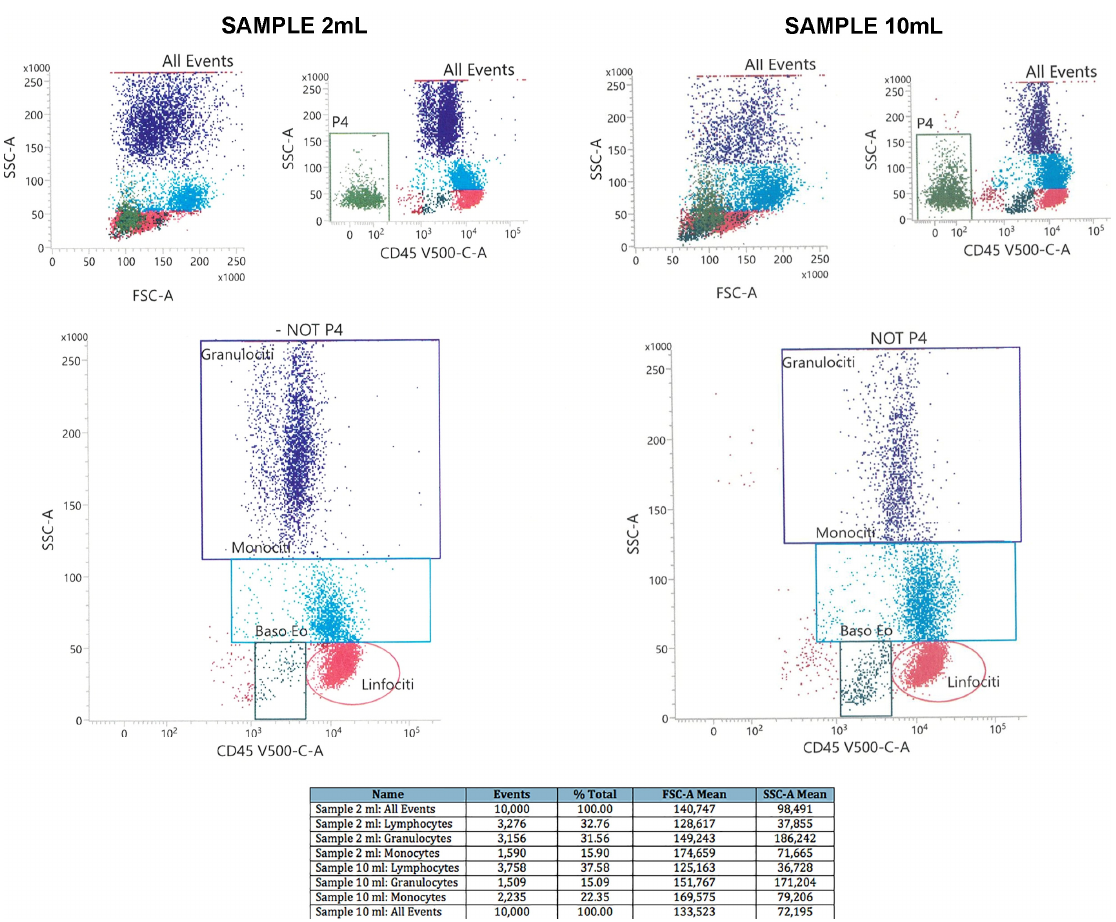
Figure 3. Flow cytometry analysis. ( Left ) Representative plot from 2 mL of initial blood volume (our new protocol); ( Right ) representative plot from 10 mL of initial blood volume (standard technique). Legend of the cell names: Granulociti : granulocytes; Monociti : monocytes; Linfociti : lymphocytes. FSC ‐ A: forward scatter area. SSC ‐ A: side scatter area. The table reports the quantification of the cell subtypes for both the sample sizes.